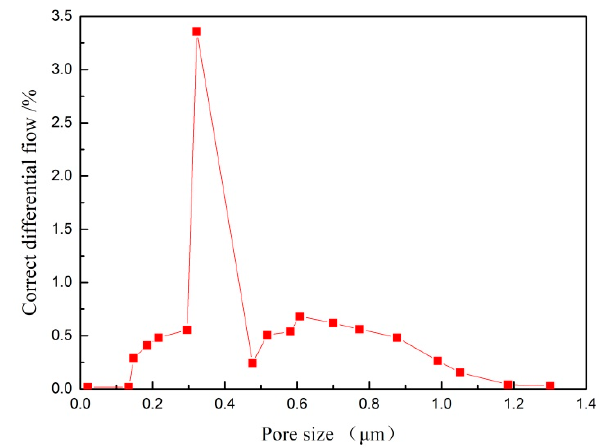
Figure 13. The pore size distribution of the TiO 2 / Ti composite membrane after oxidation under N 2 :O 2 = 2:1 at 800 °C for 60 min.